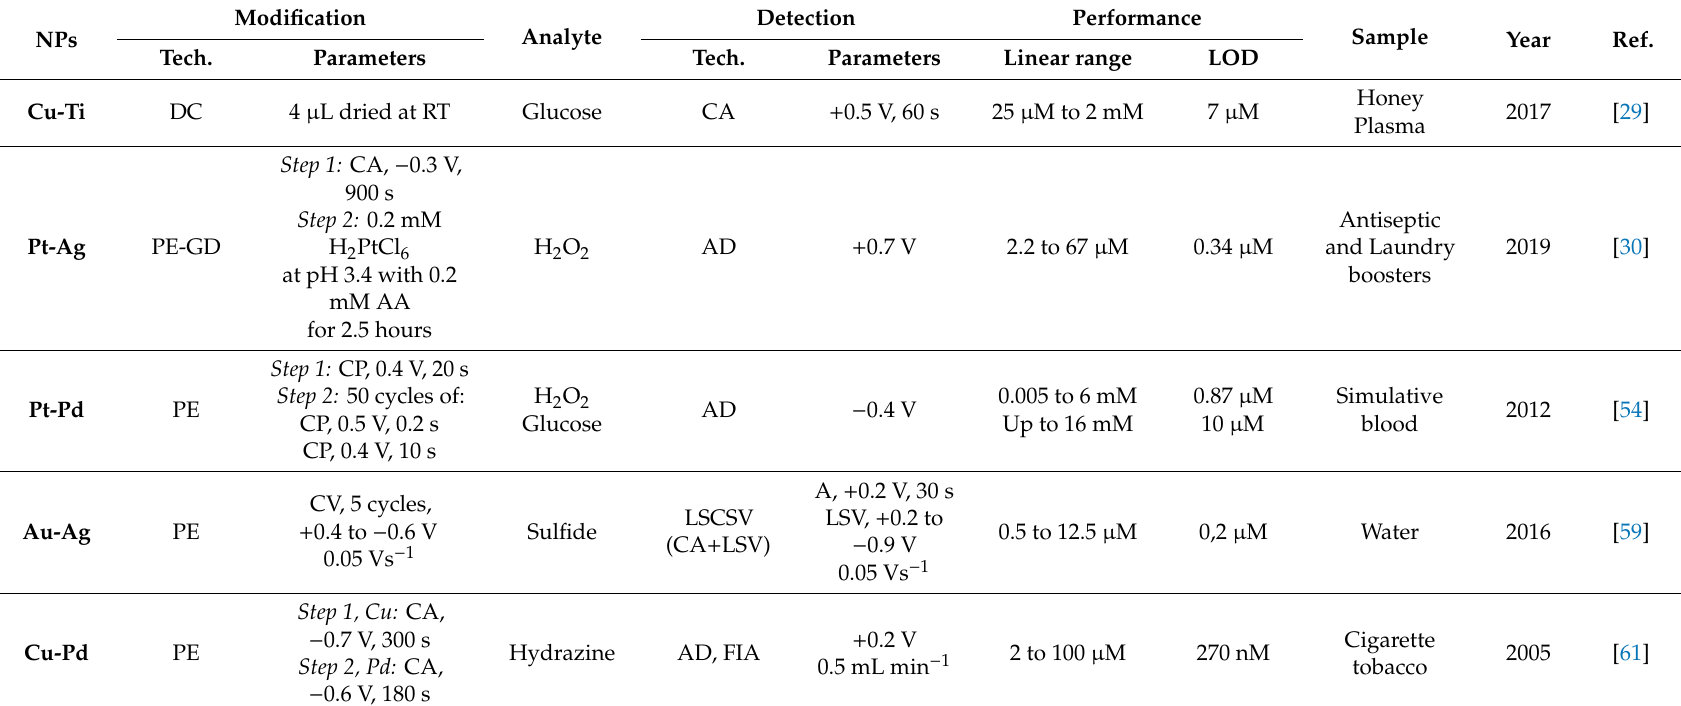
Table 2. Application of bimetallic NPs with real